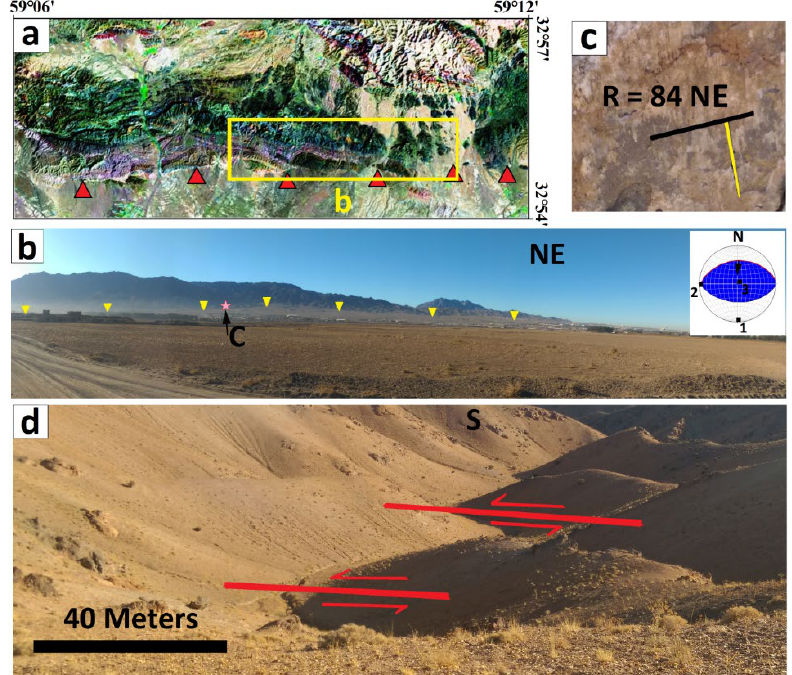
Figure 8. ( a ) Trace of F4 fault which is a reverse fault with a sinistral strike-slip component on the satellite image (shown by triangles); ( b ) field photo illustrating the uplift in Neogean sediments by F4 fault; ( c ) slicken line on the minor fault (the location is shown by a star); numbers 1, 2, and 3 in the stereonet denote the orientation of the principal stress axes; ( d ) nearly 40 m offset and tilting of rivers along the fault, arrow in the stereonet indicates the movement direction of hanging wall.